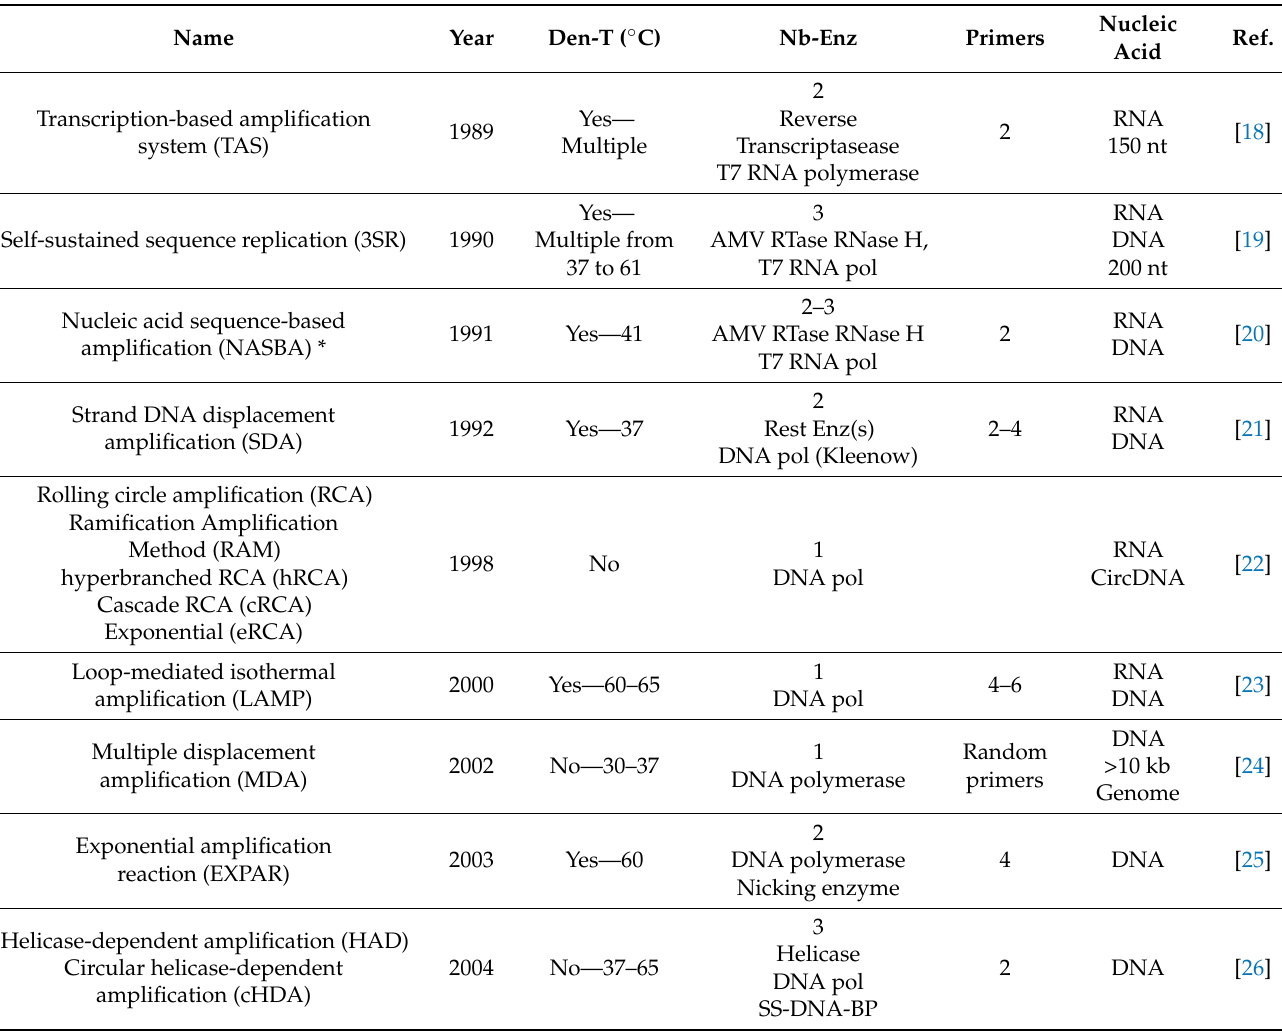
Table 1. Principal isothermal nucleic acid amplification